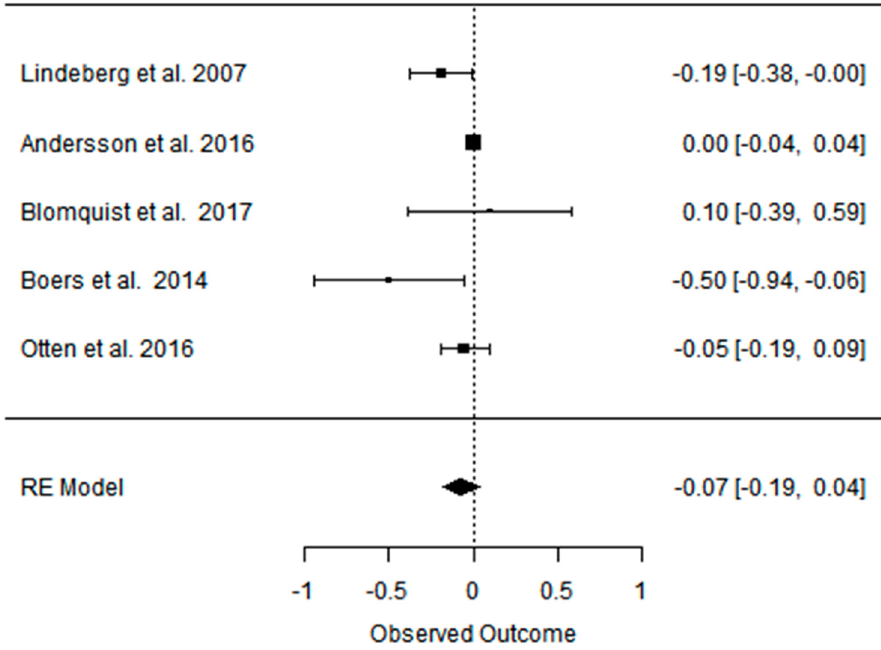
Figure A52. Forest plot of the effect of a CD on HOMA-IR in the short term (weighted mean difference).